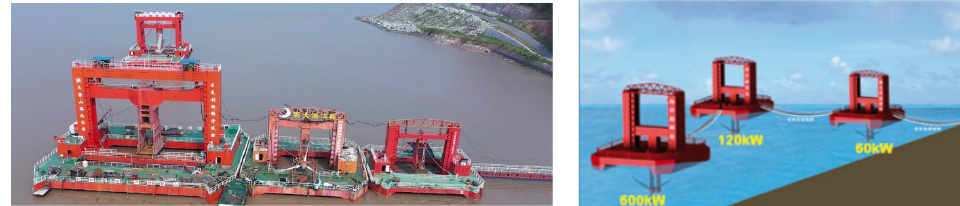
Figure 23. Array operation of multi TCPGS units of ZJU. Reproduced from [62,63].